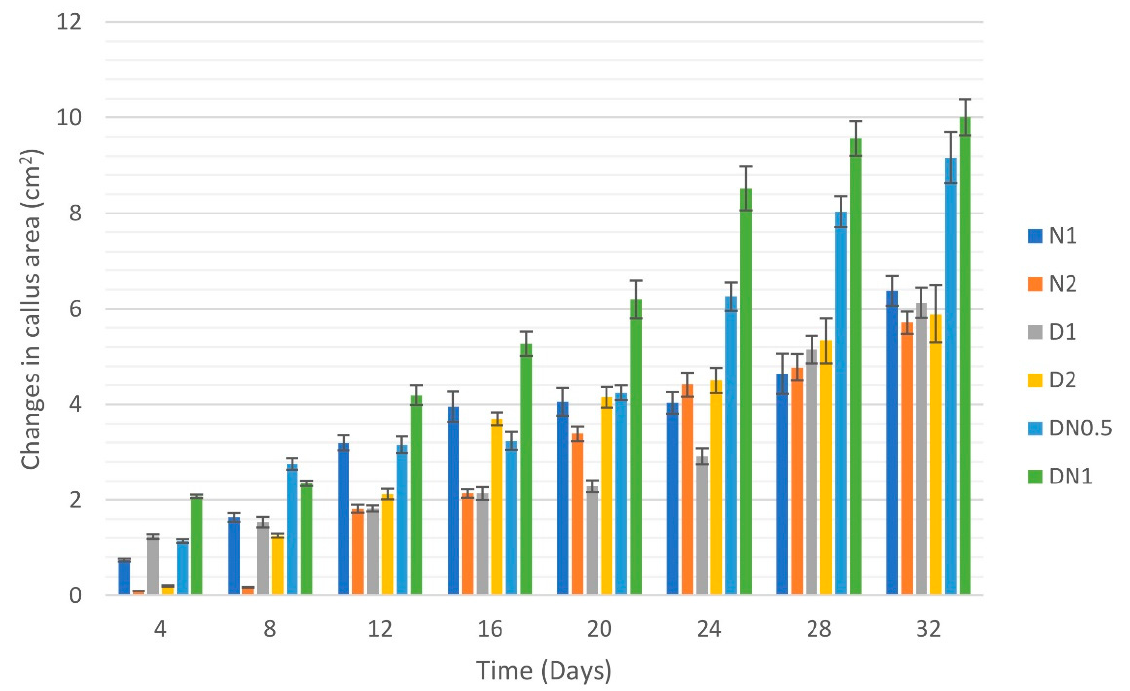
Figure 4. Changes in L. schweinfurtii callus size during 32 days of culture on MS medium supple- mented with different concentrations of NAA and 2,4-D expressed in terms of callus area in cm 2 . N1: 1 mg L − 1 NAA; N2: 2 mg L − 1 ; D1: 1 mg L − 1 2,4-D; D2: 2 mg L − 1 2,4-D; DN0.5: 0.5 + 0.5 mg L − 1 2,4-D + NAA; DN1: 1 + 1 mg L − 1 2,4-D + NAA.